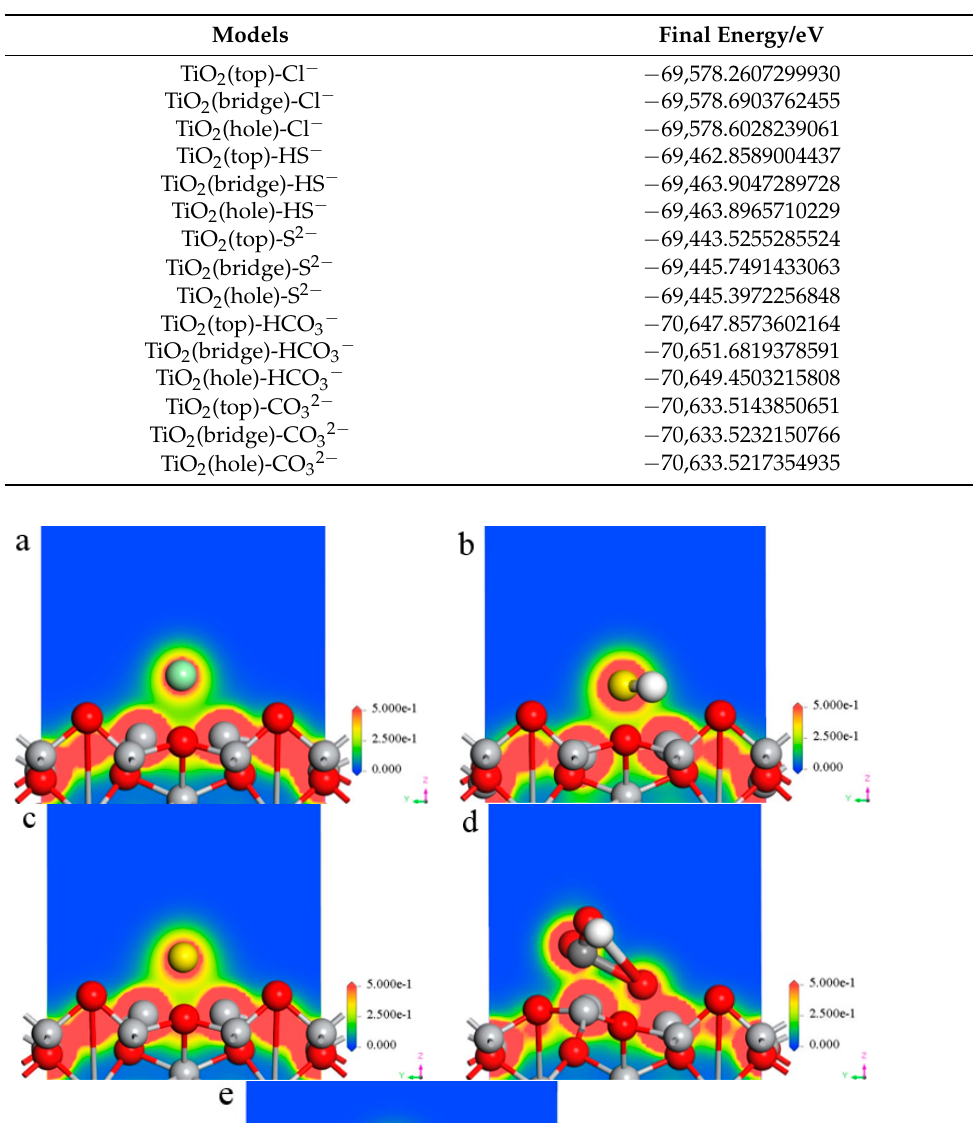
Table 2. Final energy of five corrosive ions on the TiO 2 (100) surface at different sites.